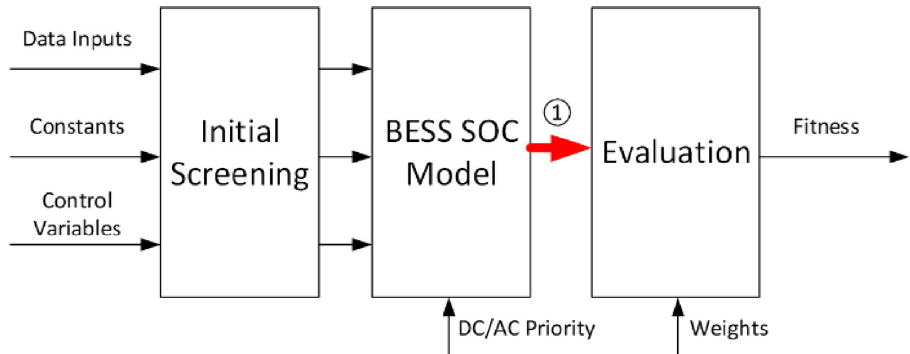
Fig 5. Block diagram representing the simulation model in the User Mode. The red arrow is explained in the text.